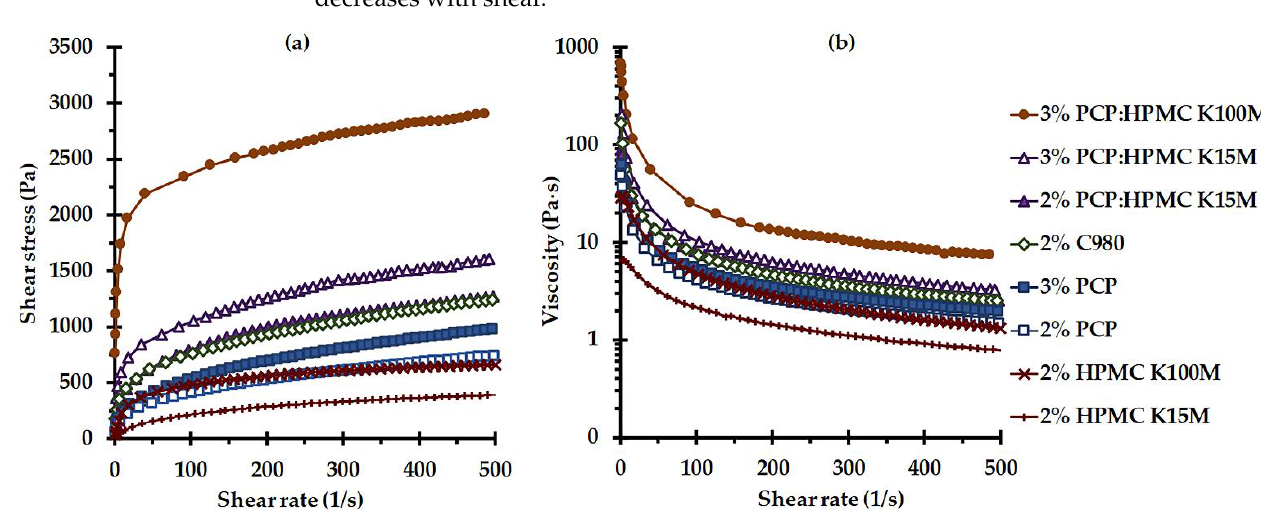
Figure 4. Flow rheograms ( a ) and viscosity – shear rate curve ( b ) at 37 °C of C. comosa mucoadhesive gels prepared from various mucoadhesive polymers.